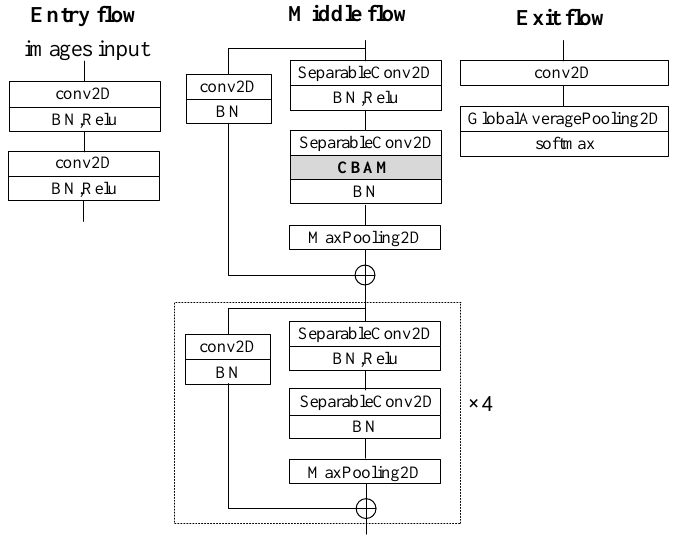
Figure 5. Diagram of model structure. Table 1. Scale tests of some lightweight